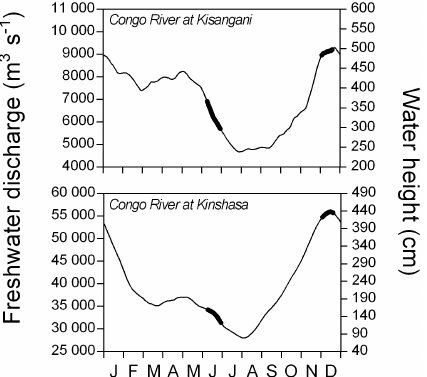
Figure 2. Average freshwater discharge of the Congo River, as well as corresponding water height at the gauging station at (a) Kisan- gani for the period 2013–2016 and (b) Kinshasa for the period 2003–2013. Timing of the two cruises is indicated by thicker